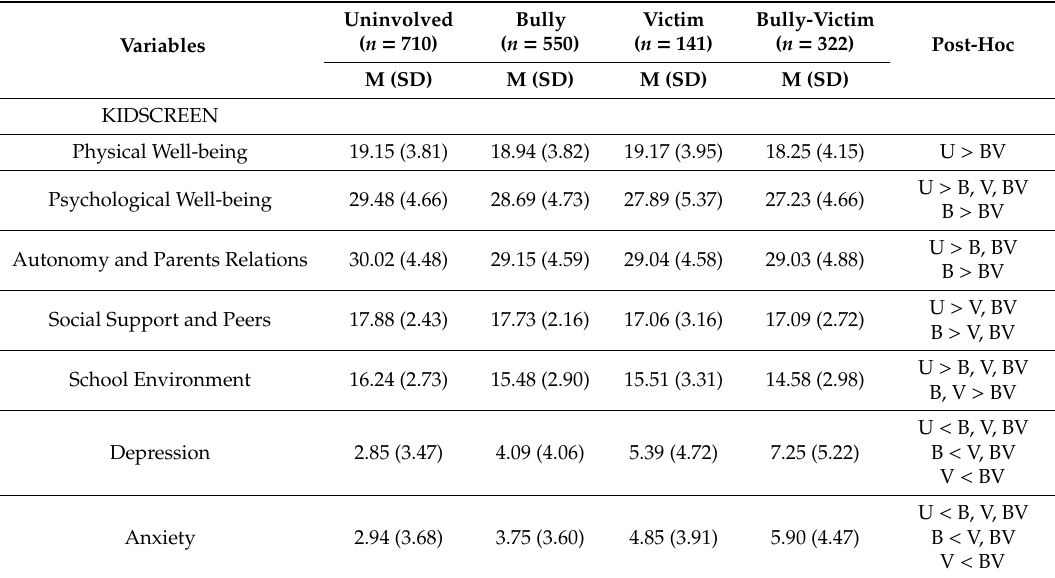
Table 3. Means and Standard Deviations in HRQoL Dimensions, Depression and Anxiety for Each Bullying Role.